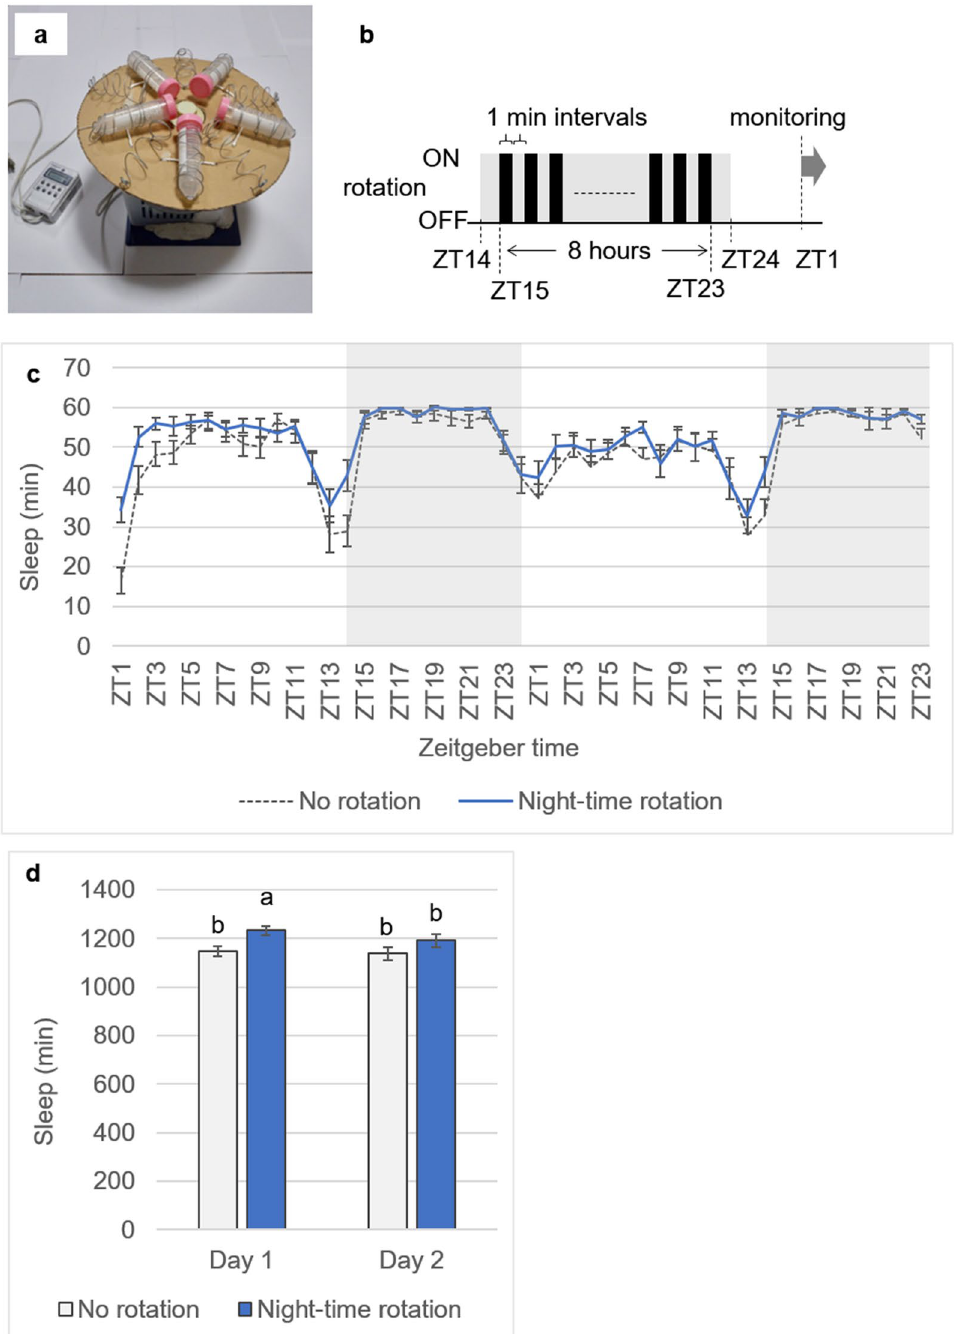
Figure 1. Sleep deprivation treatments with rotation treatments. ( a ) Custom-made centrifuge device used to provide periodic mechanical stimuli for sleep deprivation. A horizontal fibreboard disc (30 cm diameter) was installed on a fan motor. The power was controlled by a digital timer relay. ( b ) Time schedule of rotation treatments. The centrifuge device was turned on and off every minute for 8 h. Night-time rotated flies experienced the periodic mechanical stimuli from ZT15 to ZT23. The activity monitoring was started from ZT01 on the next morning. ( c ) Sleep time of flies with night-time rotation (N = 21) or without rotation (N = 22) in 1-h bins measured using the standard locomotor activity assay. Sleep rebound was found especially on the next light period following the rotation treatment. ( d ) Total sleep time in each day. Night-time rotated flies showed ca. 7.5% longer sleep than no rotation flies on day 1. Different letters indicate significant differences (α = 0.05; GLMM with Holm–Bonferroni